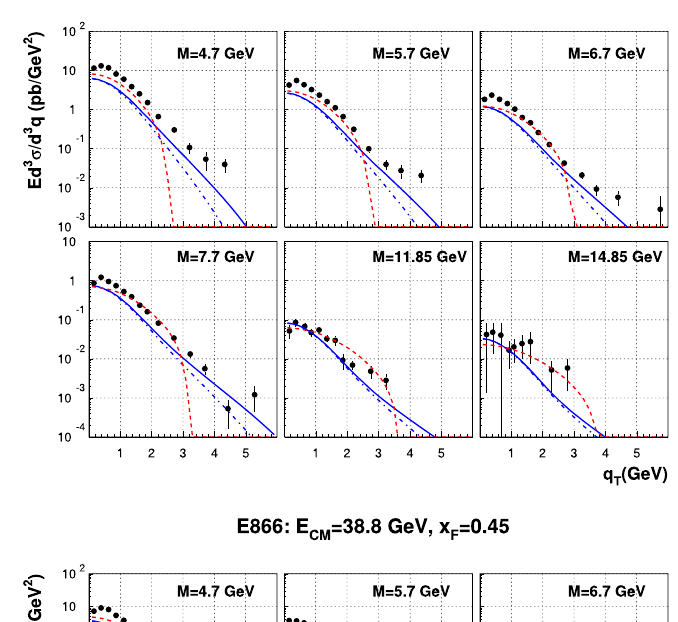
Fig. 7 Transverse momentum dependence of DY cross-section: data from fixed target experiment E866 [41] are compared with on-shell CCFM-K (blue solid), off-shell CCFM-K (blue dash-dotted) and CSS (red dashed)